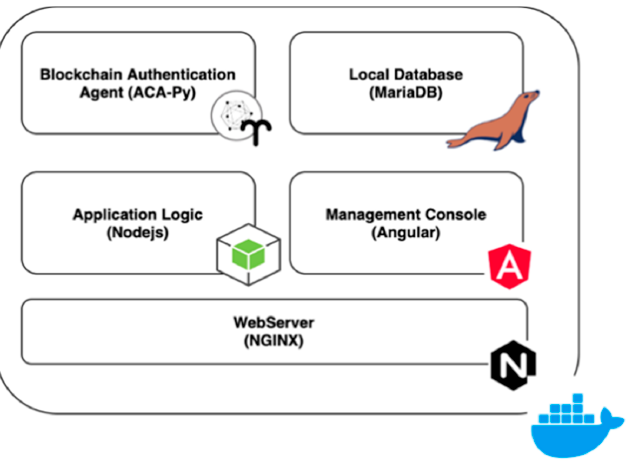
Figure 10. Electro Mobility Service Provider (EMSP) platform software infrastructure.